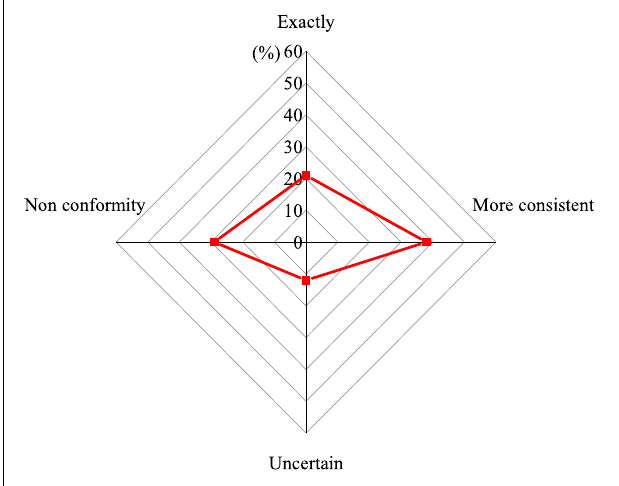
Figure 5A , the average value of obsessive- compulsive symptoms from the SCL-90 has reached 2.15 scores, and the average value is largest.